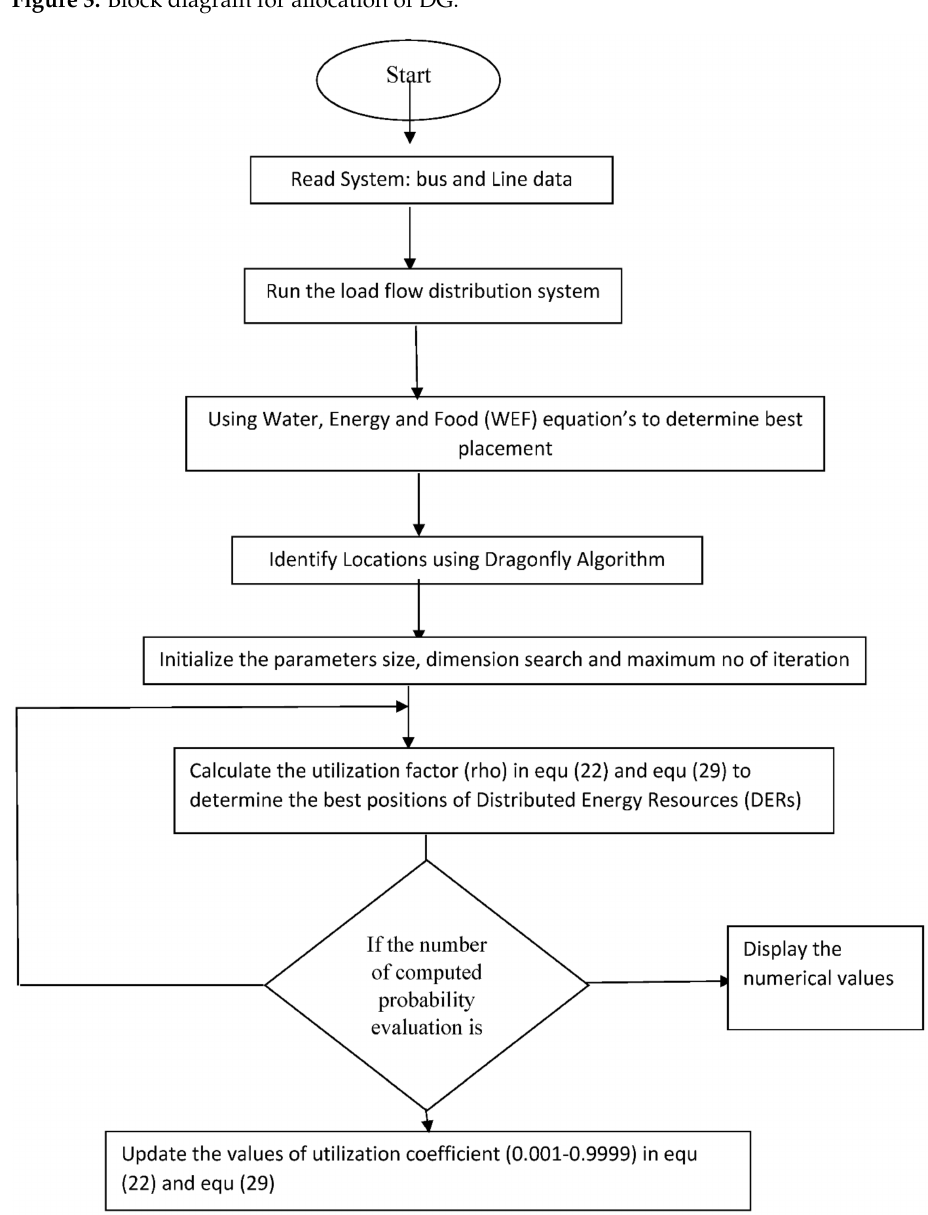
Figure 4. Optimal DG allocation